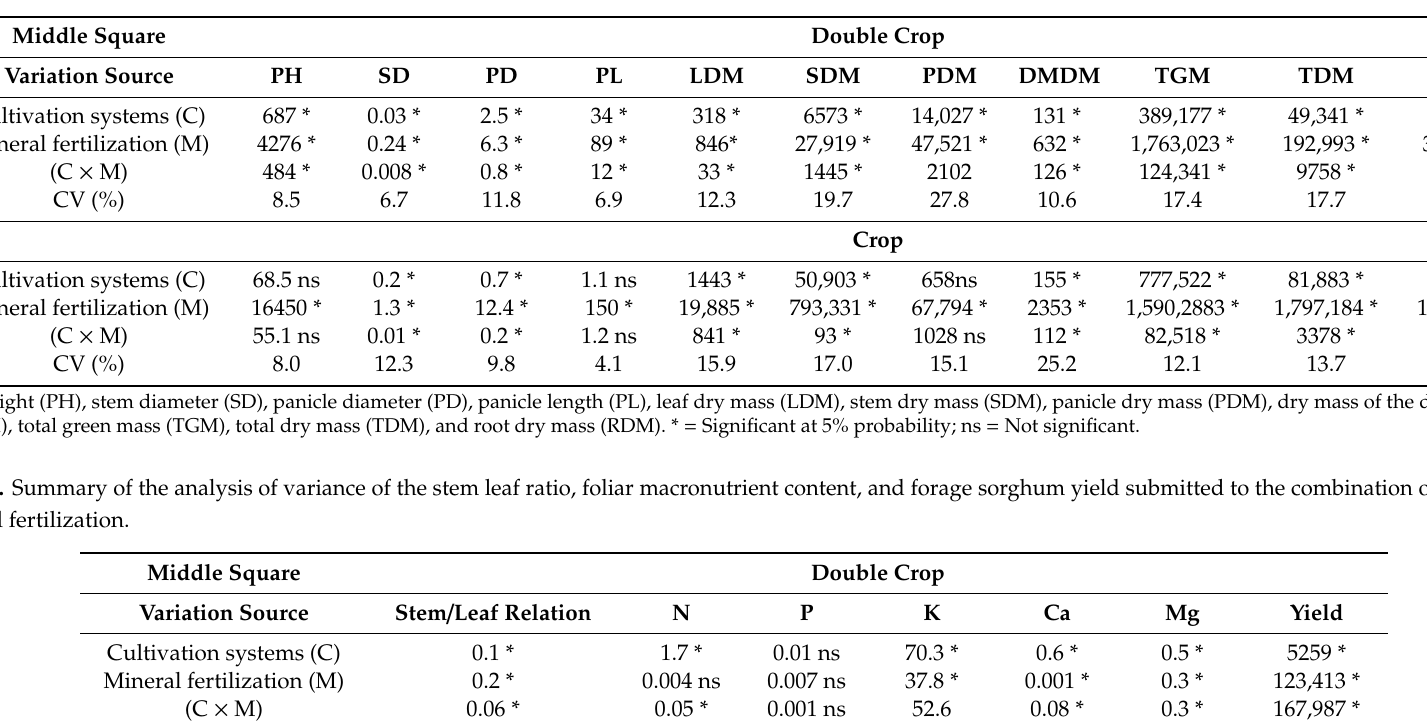
Table 3. Summary of the analysis of variance of the growth components as well as the dry mass of the morphological components and total forage sorghum submitted to the combination of legume alleys and mineral fertilization.